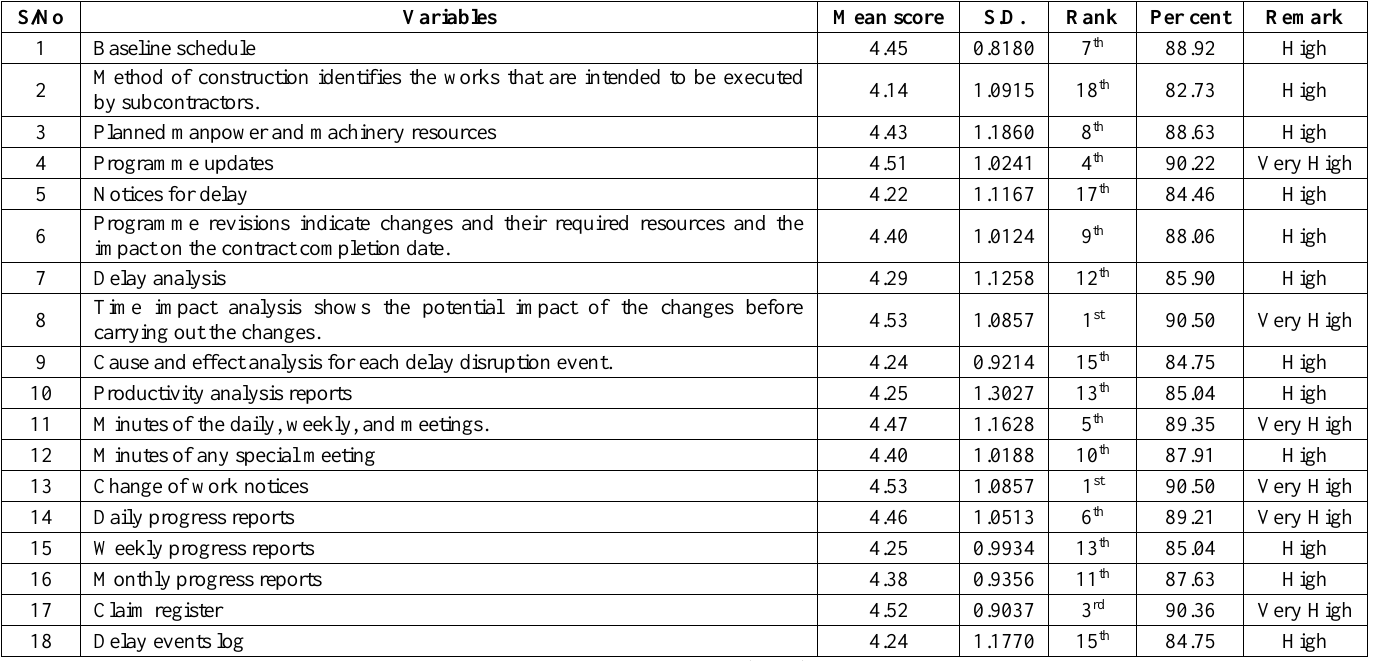
Table 5: List of required records to establish properly substantiated EoT claims.